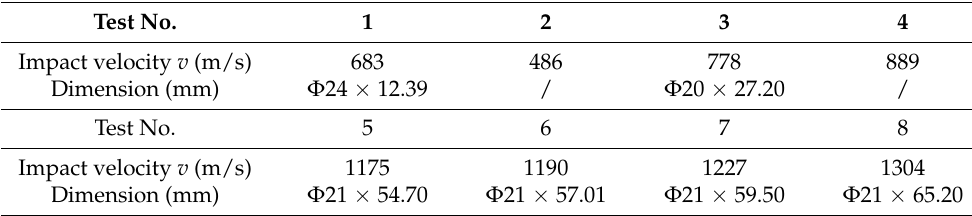
Table 12. Perforation dimension of armor with three layers of PE. Test No.